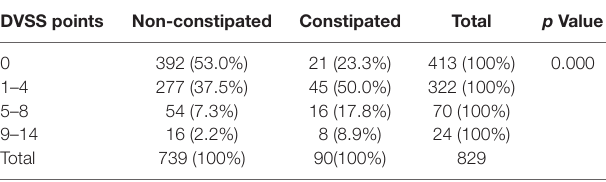
TaBle 4 | Final score obtained in DVss, without constipation questions, for constipated and non-constipated children. DVss points